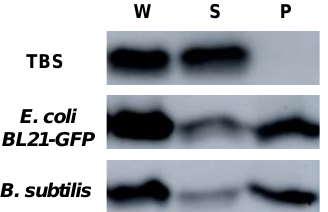
Figure 9. Bacterial binding analysis of rAbCTLD resuspended in 0.05% dodecyl maltoside. Bacterial binding analysis was performed on purified rAbCTLD together with E . coli or B . subtilis . Precipitates were separated by centrifugation, and purified recombinant proteins were dissolved in 0.05% dodecyl maltoside, then incubated with E . coli or B . subtilis as indicated. Tris-buffered saline (TBS) replaced bacterial cells in the control samples (TBS). The levels of rAbCTLD in the whole reaction mixture (W), supernatant (S), and pellet (P) were compared by immunoblotting analysis using an anti-His tag antibody.